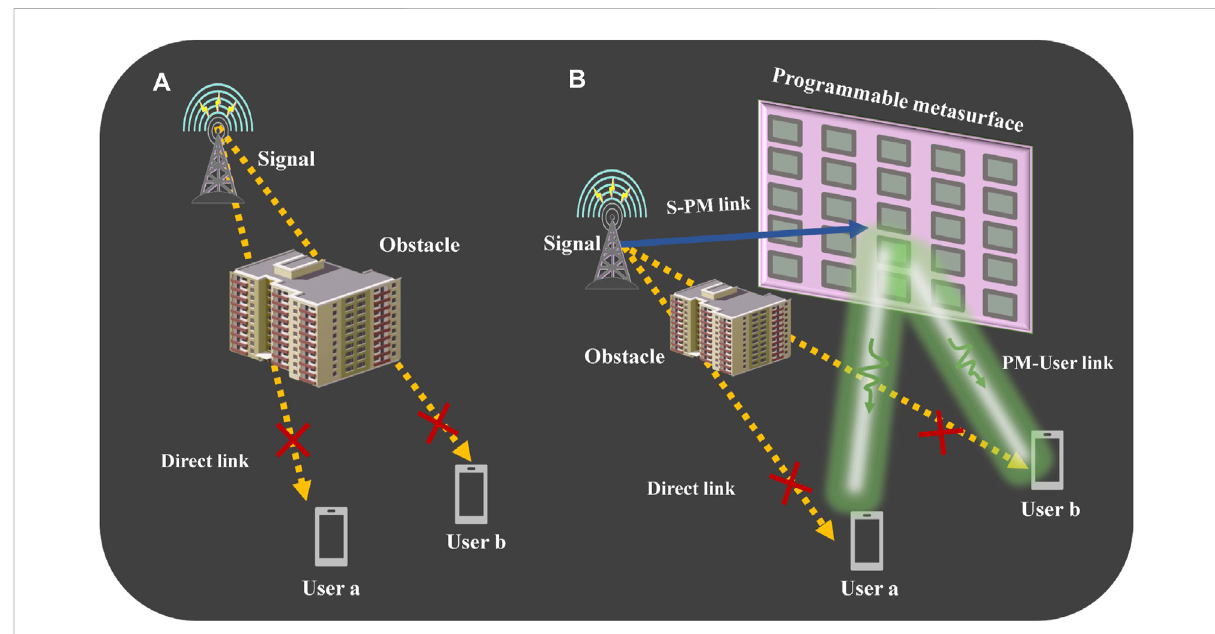
FIGURE 1 Schematic diagram of communication scenario. (A) . Obstacles block user communication. (B) . The direct link between the signal source and users is blocked by obstacles. Signals can be propagated to User a and User b when establishing an “ S-PM ” link between the signal source and